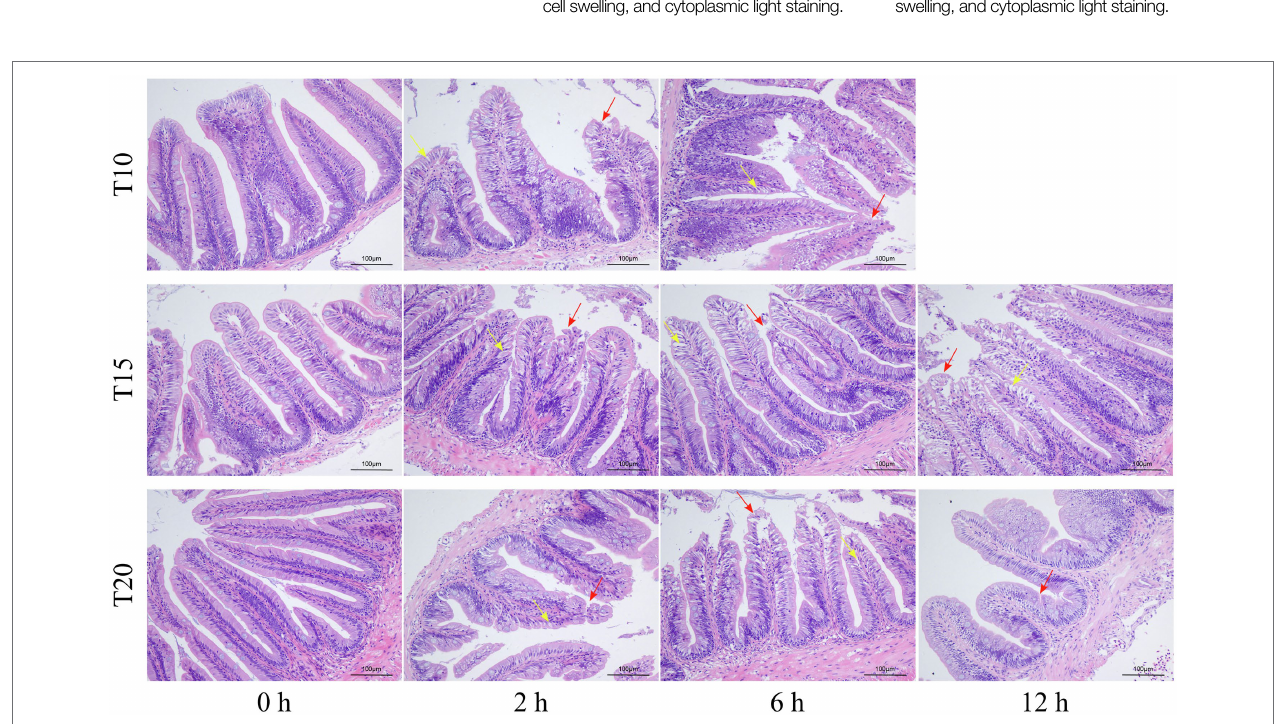
FIGURE 2 | Sections of intestinal tissue of heat stressed O. stewarti juveniles with different acclimation histories. T10, T15, and T20 indicate 10 ° C, 15 ° C, and 20 ° C acclimation temperature backgrounds of the experimental fish. The values 0–12 h represent the duration of the heat stress. The red arrows show necrosis and shedding of intestinal villous epithelial cells; the yellow arrows show edema, swelling, and cytoplasmic light staining in the intestinal villous epithelial cells.